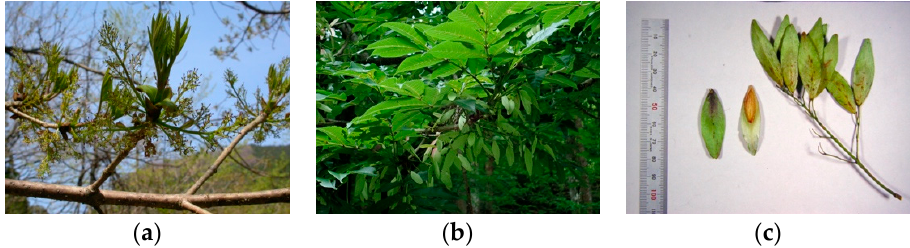
Figure 5. Fruit development in Fraxinus platypoda . ( a ) Small fruits after flowering on 28 April. ( b ) Fruits with no seeds on 12 June. ( c ) Seeds in pericarps in autumn.